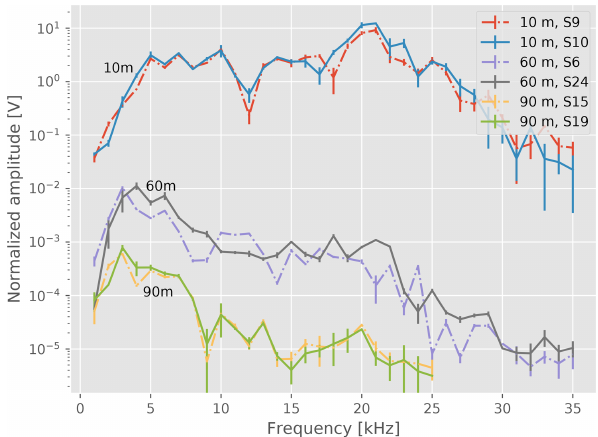
Figure 10. Normalized amplitudes for 16kHz sine bursts. Varia- tions in measured amplitudes for measurements of different hole pairs at 20, 40, and 60m are indicated.